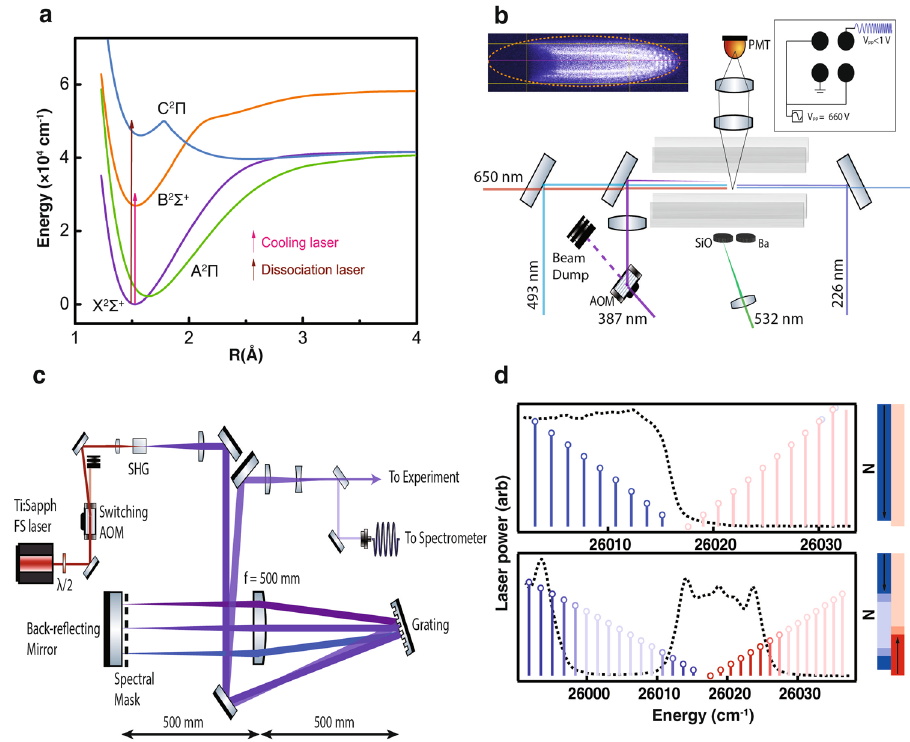
Fig. 1 Experimental Overview. a Relevant electronic states of SiO + . b Experimental setup, a bright barium ion Coulomb crystal with a dark SiO + core is loaded into a linear Paul trap by 532 nm ablation, and translationally cooled using 493 nm and 650 nm Ba + transitions. SiO + is pumped with 385 nm and probed with 226 nm. A low-amplitude chirped RF waveform is used for LCFMS detection. c Spectral fi ltering setup for the 385 nm broadband light. d Spectrum of the 385 nm light used for pumping SiO + toward N = 0 (top) and N >0 (bottom). Blue (red) sticks represent transitions in the P (R) branch. Arrows to the right show the fl ow of optical pumping, with blue (red) representing lowering (raising) N , and shading represents intensity of the